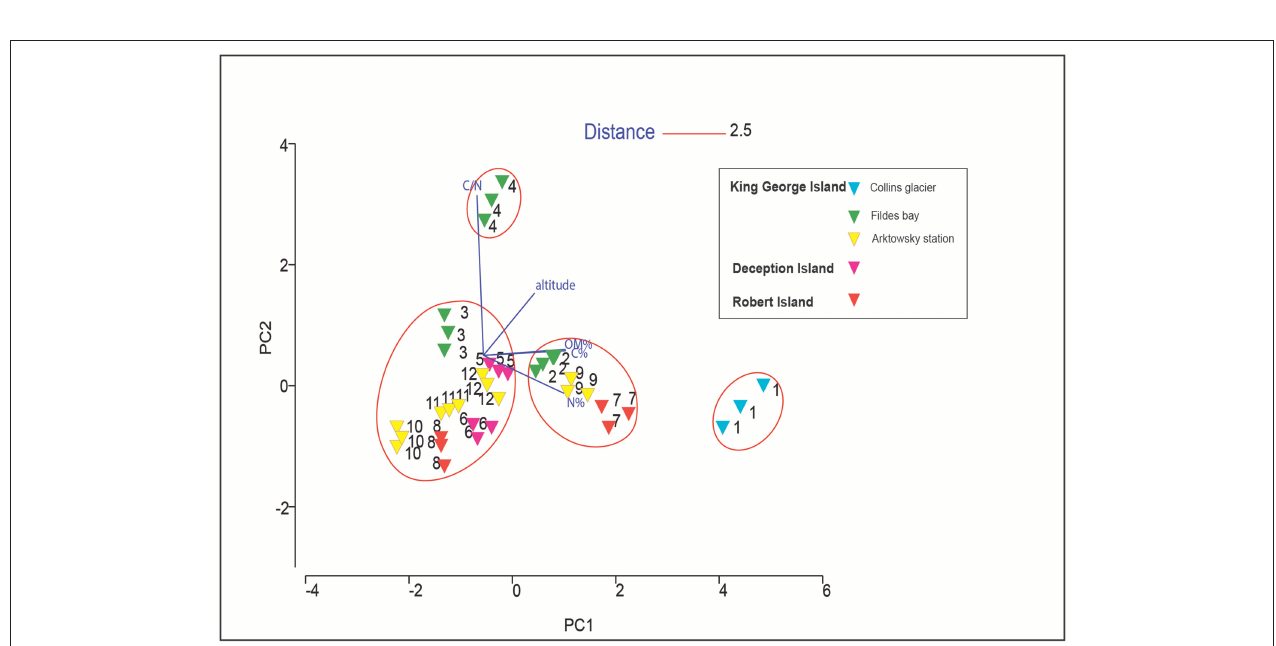
FIGURE 2 | Principal component analysis (PCA) analysis based on the chemical properties of 12 Antarctic soil samples.